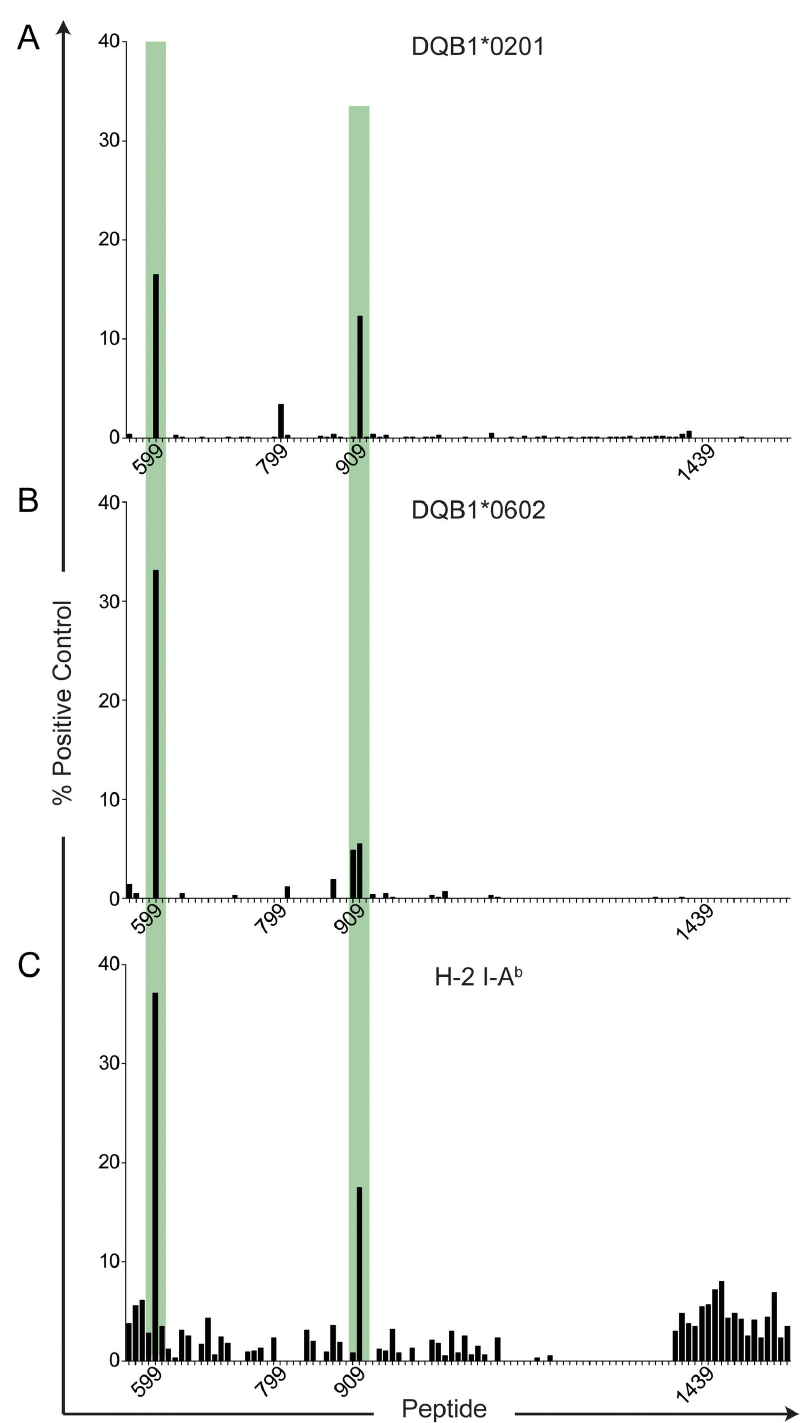
Figure 4. α1(V) peptide binding to HLA-DQ2, HLA-DQ6 and mouse H-2 I-A b . ProImmune REVEAL MHC-peptide binding assay screen of 5-amino acid overlapping peptide library (101 total peptides) of the α1(V) helical domain to HLA-DQ2 (A), HLA-DQ6 (B) and H-2 I-A b (C). Each MHC:peptide binding score is based on known binding of a positive control peptide and a weaker binding positive control peptide. MHC:peptide binding scores above 12% are considered positive and have potential for immunological activity. Lack of bar for a peptide represents a score of 0%. Peptide number corresponds to the location in the α1(V) AA sequence. Green shaded areas indicate where HLA-DQ2, -DQ6 and H-2 I-A b similarly bound within the helical domain. doi: 10.1371/journal.pone.0079601.g004 PLOS ONE |